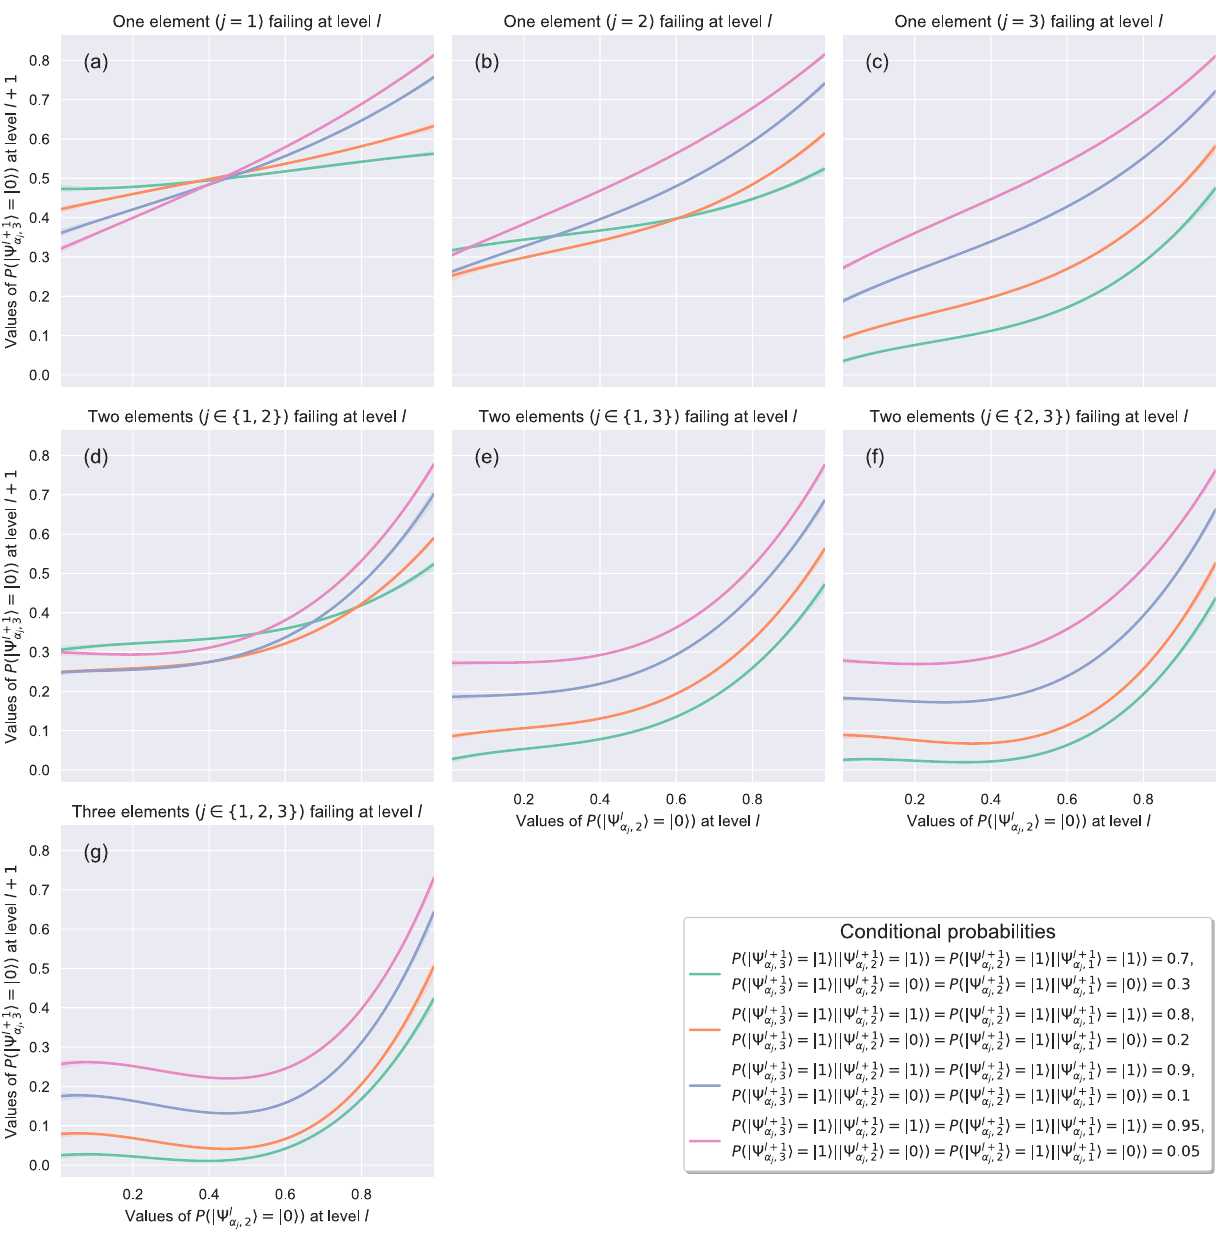
Figure 5. Performance loss of the system at level l + 1 for different failure behaviors at level l and different 1 � = | a � ) , where i ∈ { 2, 3 } and | a � ∈ {| 1 � , | 0 �} . Second approach. Three � = | 1 �|| � l + 1 combinations of P ( | � l + α j , i α j , i − 1 qubits